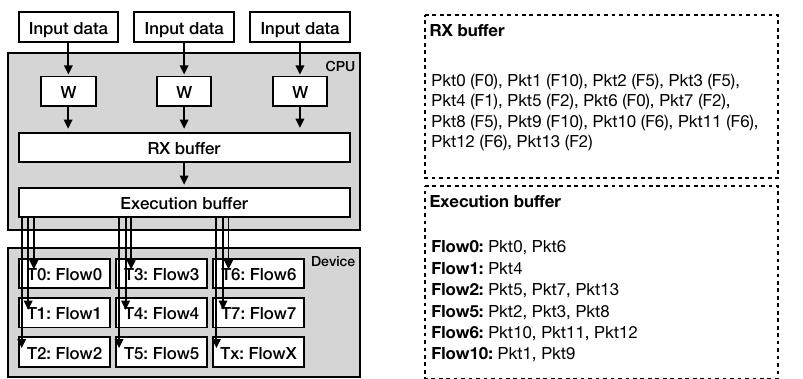
Figure 6. Overview of the packet processing architecture. Each worker thread is assigned to a single input source, transferring the packets into the RX buffer. The RX buffer continuously receives packets, copying its contents to the execution buffer, where the packets are divided into flows, ordered and copied to the device’s memory address space for processing. Each compute kernel thread is assigned to a single